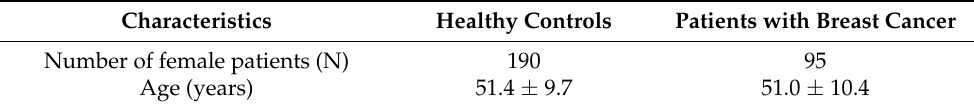
Table 1. Characteristics of healthy controls and patients with breast